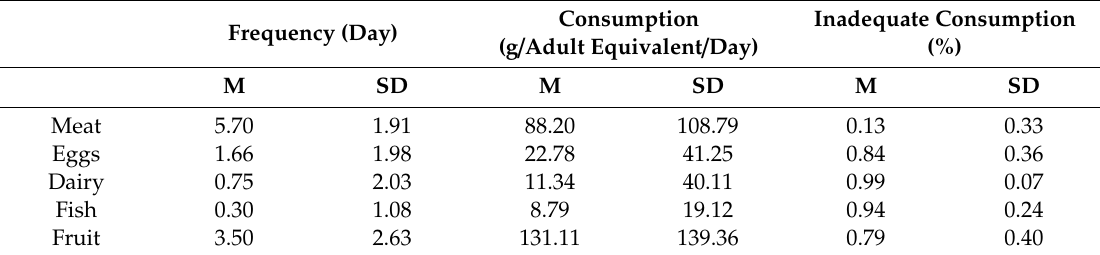
Table 2. Food consumption status of the study sample ( n =